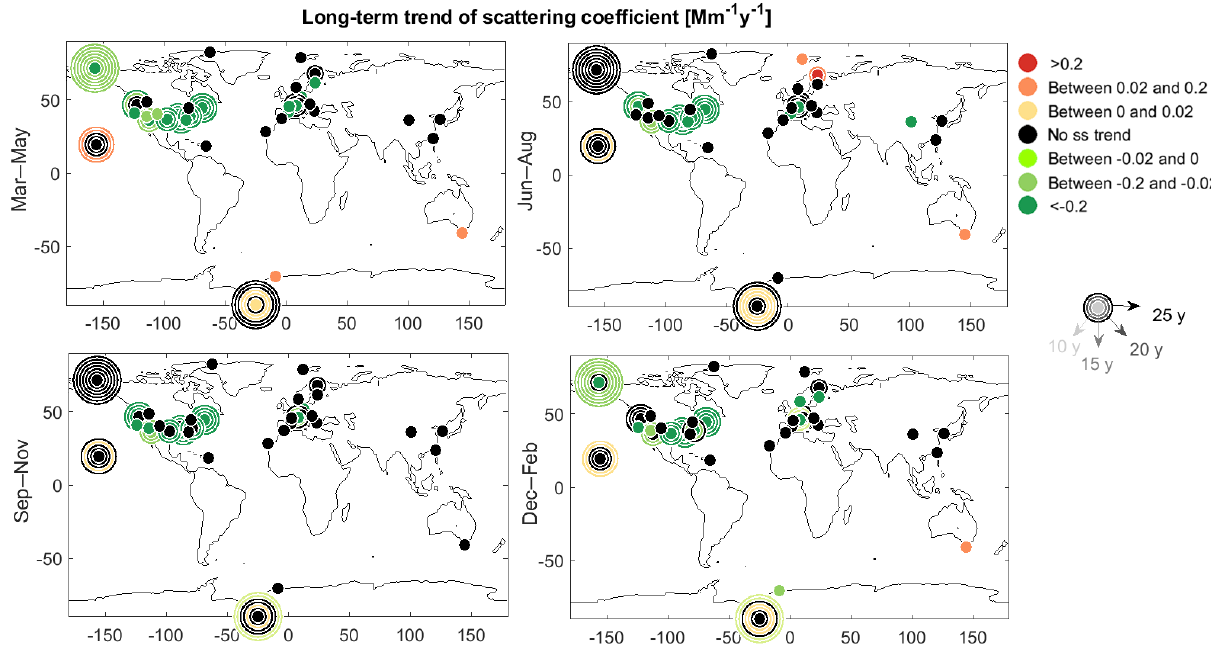
Figure 5. Seasonal results of the MK trend of the scattering coefficient. Other details same as Fig. 4.